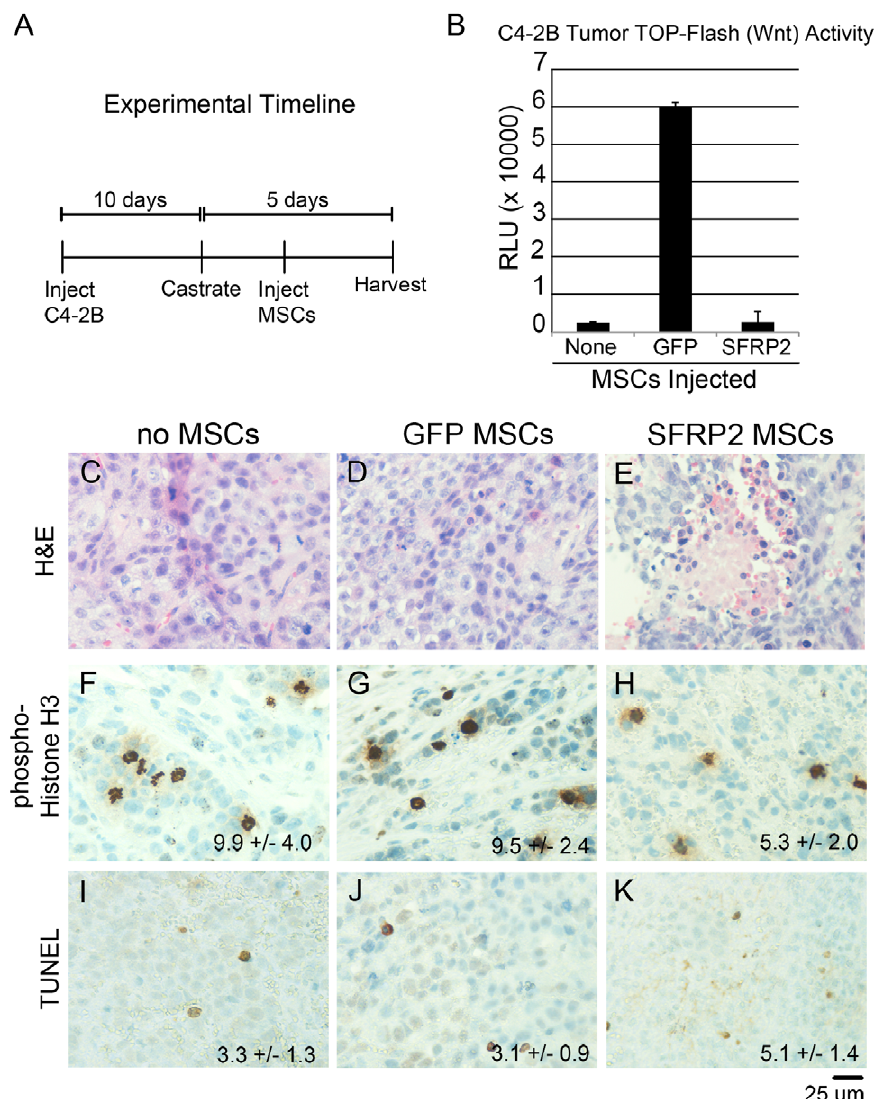
Figure 6. GFP-MSCs recruited to human CRPC xenografts enhanced Wnt signaling. A) The experimental setup is summarized in the timeline. C4-2B cells were orthotopically injected into the prostates of SCID mice. After 10 days the mice were castrated and MSCs were given 24 hours following castration. The tumors were harvested five days following castration. B) TOP-Flash luciferase activity was measured in C4-2B tumors. GFP-MSCs increased Wnt activity within the tumors by 24-fold compared to control uninjected tumors. SFRP2-MSCs suppressed Wnt activity comparable to basal levels. C4-2B tumors were sectioned and stained for histological analysis five days following castration. C4-2B tumors had necrosis in the C) absence of MSCs, D) GFP-MSCs, and E) the greatest in SFRP2-MSC injected mice. F) Basal levels of phosphorylated histone-H3 were observed in tumors without MSCs and G) GFP-MSCs. H) Proliferation was significantly decreased in tumors with SFRP2-MSCs (p value =0.0069). I) Basal levels of TUNEL-positive apoptosis were found in tumors without MSCs and J) GFP-MSCs. K) A significant increase in apoptosis was seen in tumors with SFRP2-MSCs (p value =0.0066). Areas of necrosis were avoided in quantitating TUNEL positive cells.